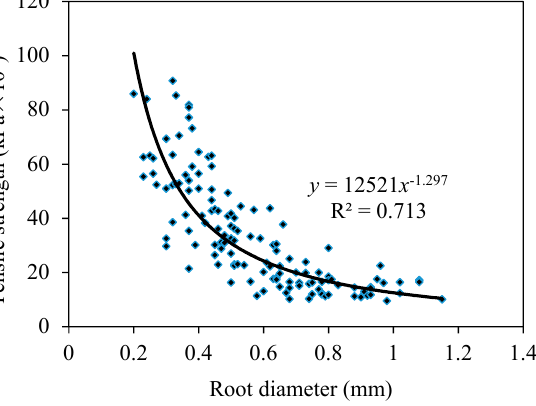
Figure 4. Relationship between root tensile strength and root diameter of Blysmus sinocompressus Tang et Wang.